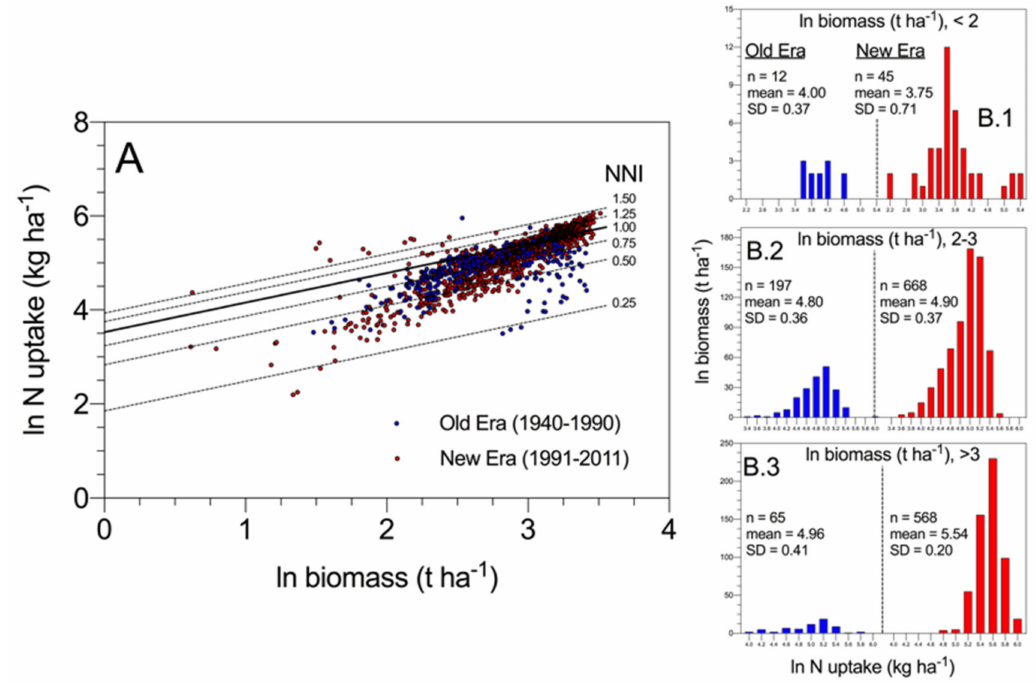
Figure 6. Panel ( A ) represents a log–log scale (similar symbols) of changes in N uptake and biomass for historical maize hybrids with respect to with their NNI level at maturity. Higher e ffi ciency in the conversion of N uptake to yield is not necessarily connected to changes in N dynamics but to the ability of modern maize hybrids to increase plant growth and attainable yield. NNI = 1 refers to the calculation presented in Figure 2. Panels ( B.1 – B.3 ) represent data retrieved from Ciampitti and Vyn (2012)